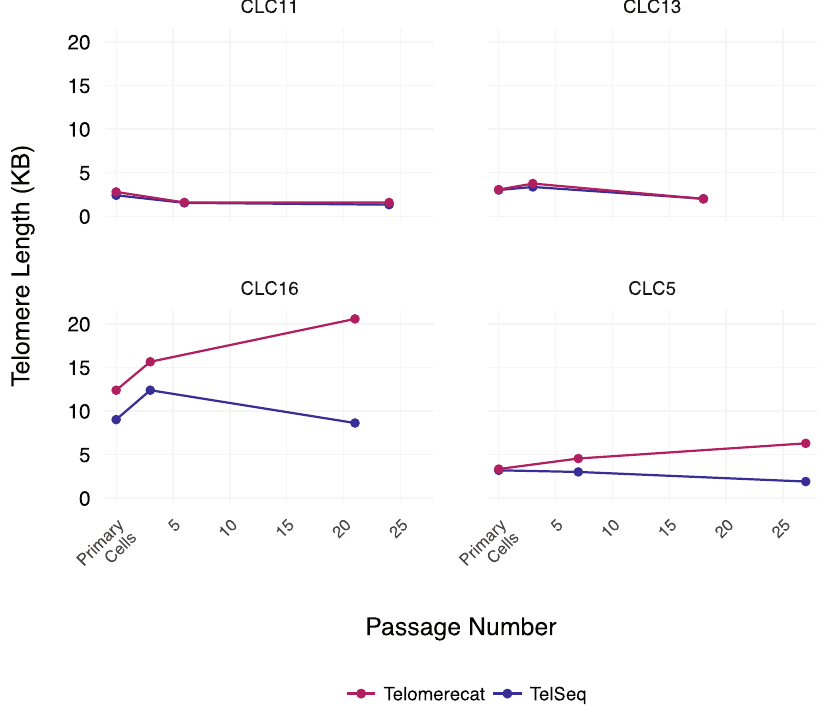
Figure 3. Telomerecat and TelSeq estimates for the HCC cell line dataset.